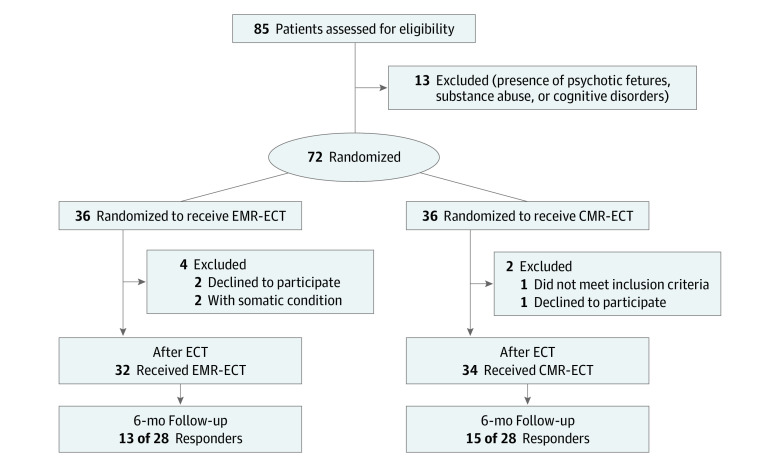
Patient Flow DiagramCMR-ECT indicates control memory reactivation ECT; ECT, electroconvulsive therapy; and EMR-ECT, emotional memory reactivation ECT.